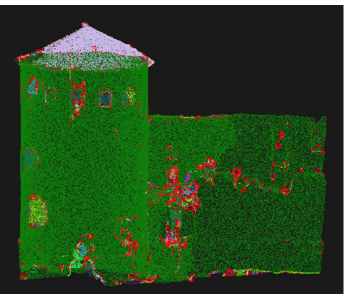
Figure 9. Region growing algorithm applied on the point cloud